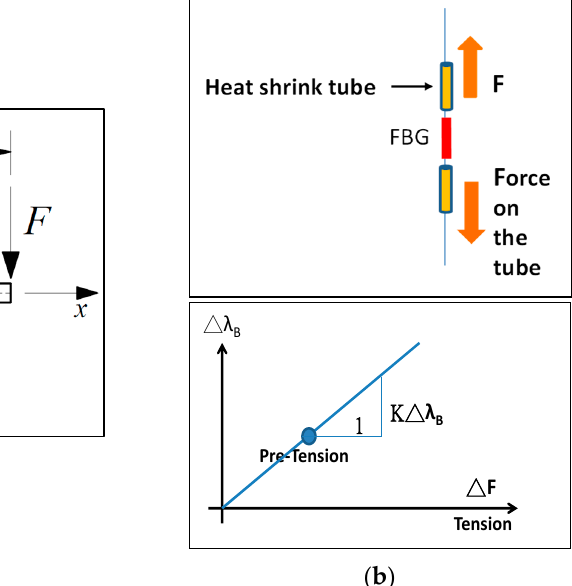
Figure 2. FBG-based displacement sensors according to wavelength shift demodulation: ( a ) Schematic of a proposed cantilever-based sensor. The positions of the two FBGs, at distance L s between each other, are shown along with the effective cantilever length L ; ( b ) mechanism of a proposed two-fixed-ends-based sensor. Heat-shrink tubes at both ends of an FBG that exert an external tensile force F on the FBG (top). Variation in the external tensile force Δ F with variations in the central wavelength Δλ B (bottom).